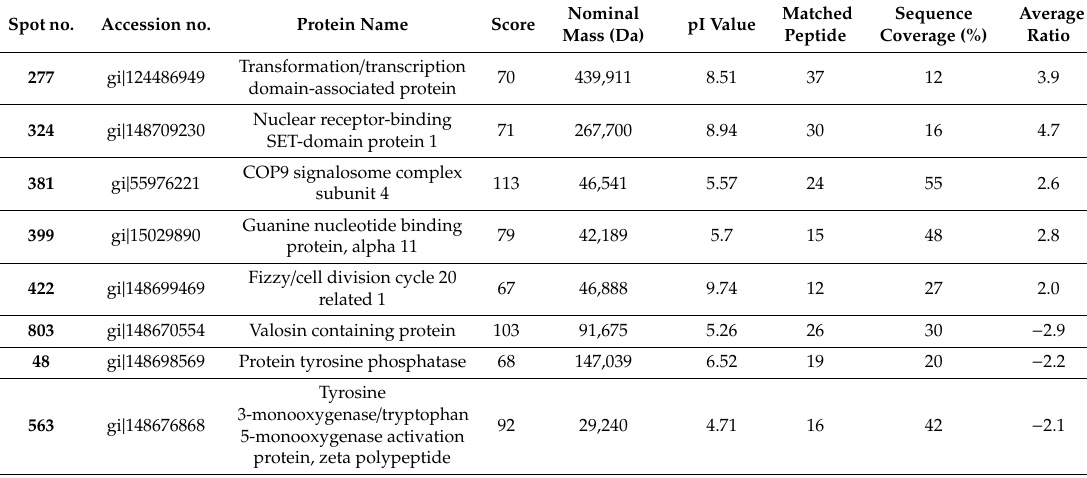
Table 2. Di ff erentially expressed proteins related to cell signaling and processes after entacapone treatment in the hippocampus.